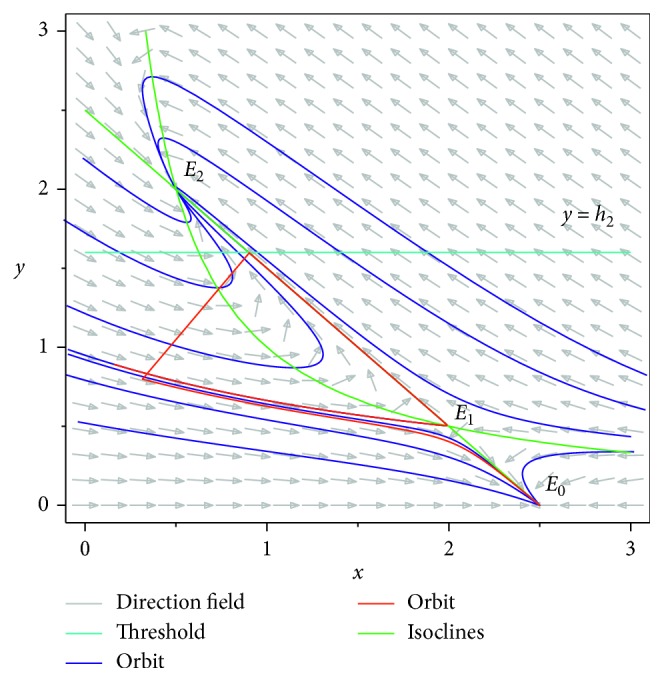
Phase diagram of system (3) with p=0.65.